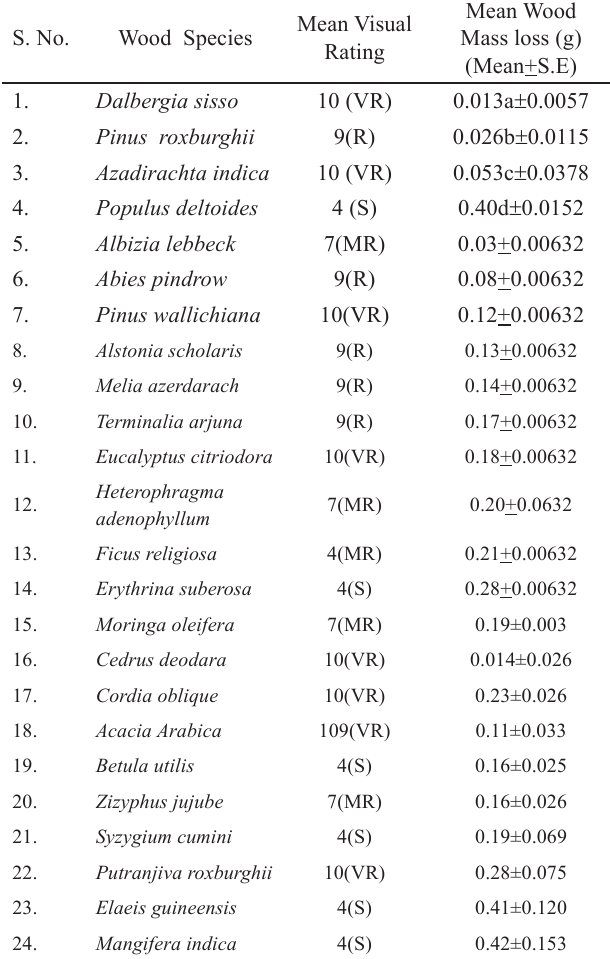
Table 2. Mean Visual Rating and Mean Wood Mass loss of various wood species during No Choice feeding bioassay against C. heimi (Wasmann) in the